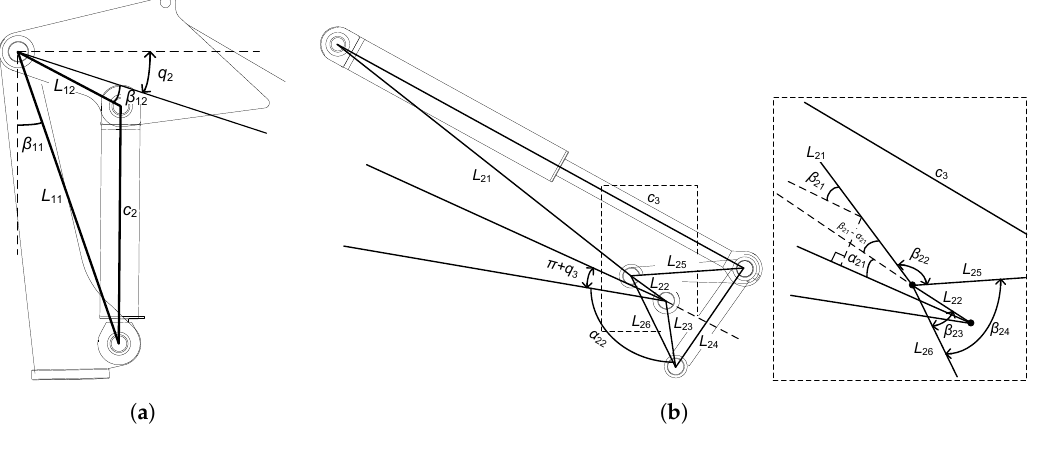
Figure 8. Joint actuation mechanisms of the test-bed manipulator: ( a ) Lift joint and associated variables; and ( b ) tilt joint and associated variables, with a